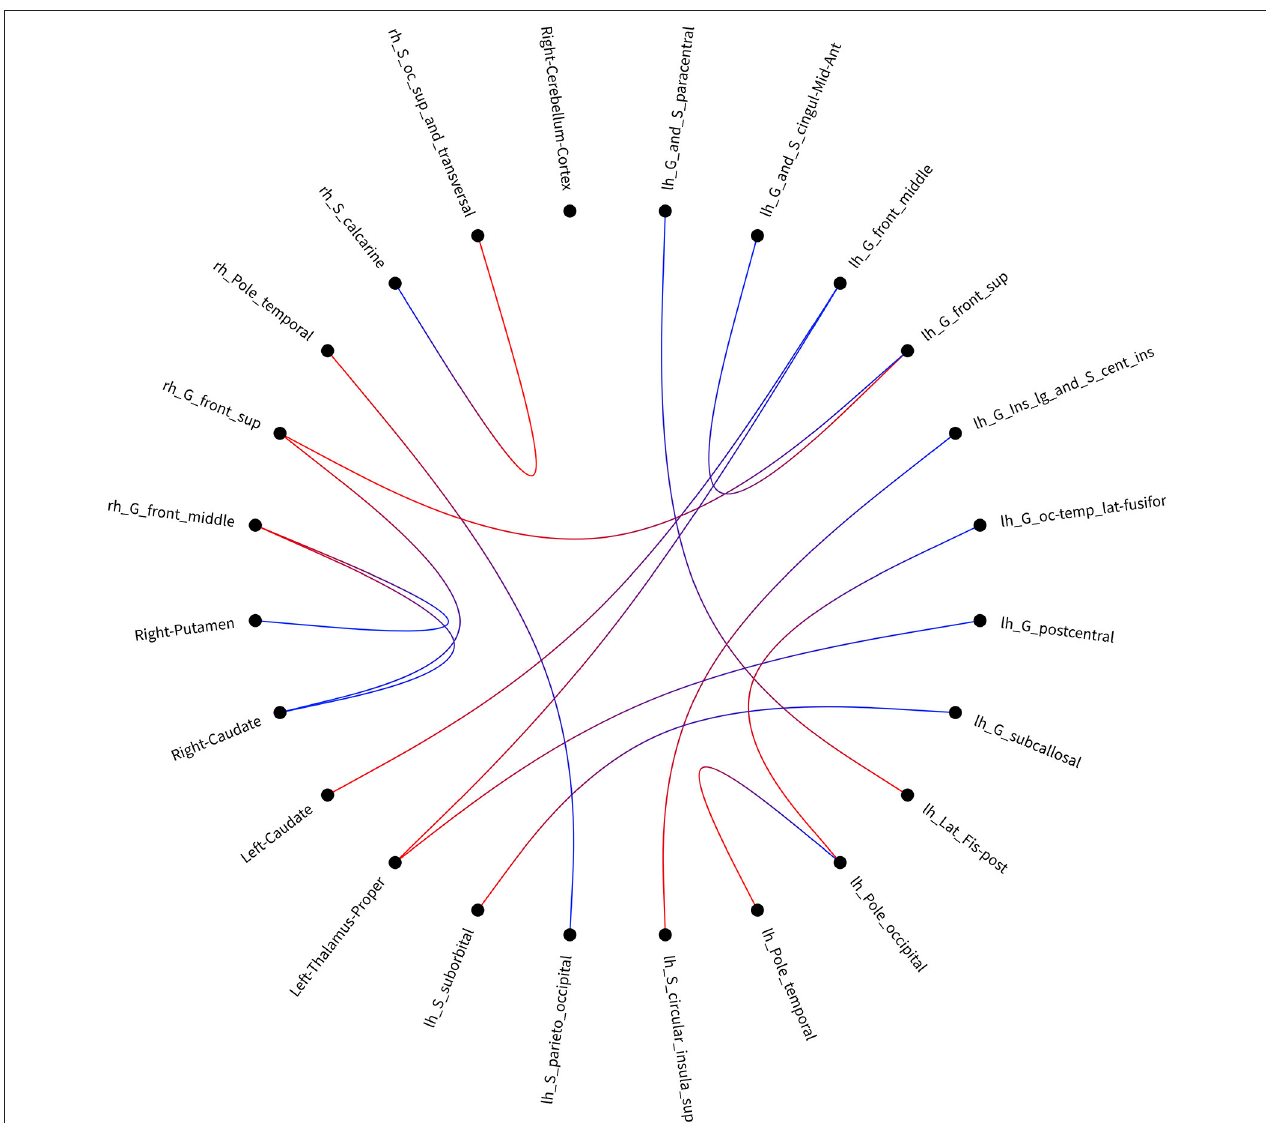
FIGURE 3 | Visualization of the disrupted connectivity matrix found in the group comparison when using link-based analysis. lh, left hemisphere; rh, right